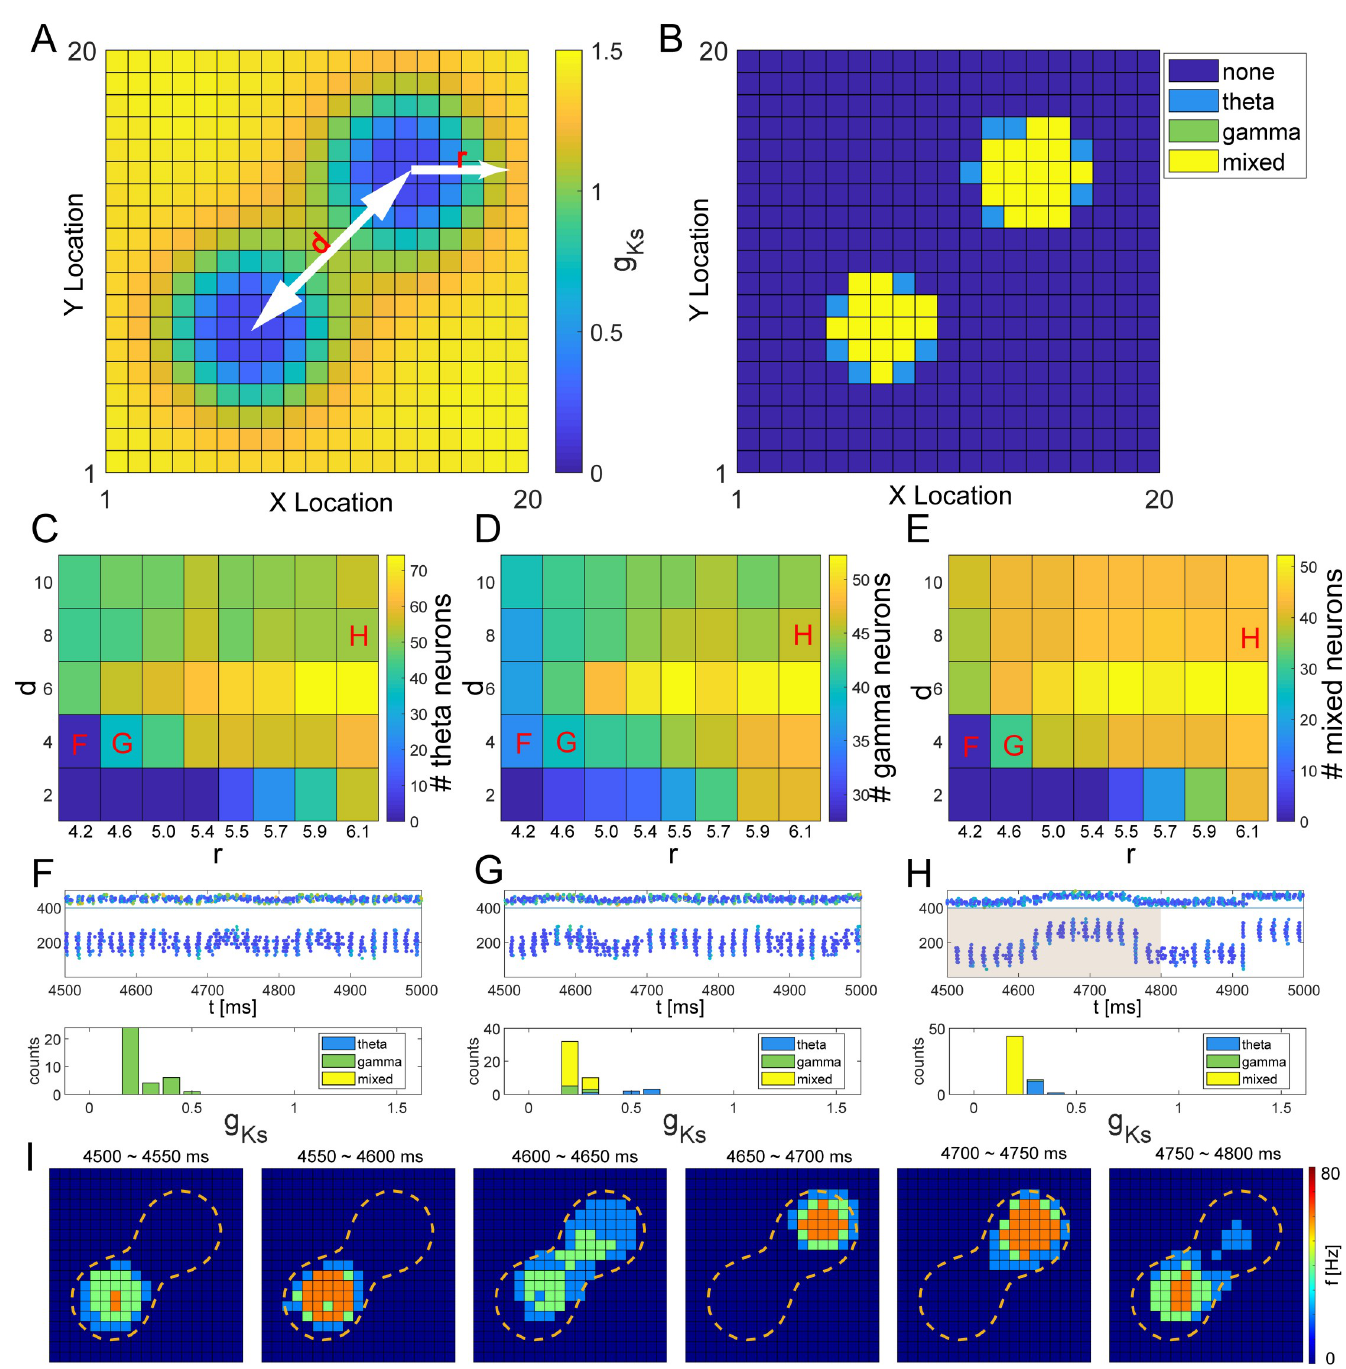
Fig 4. Theta/gamma band rhythms generated with a double peaked spatial distribution of g Ks . A, Example of double peaked spatial mapping of g Ks values for corresponding neurons on the 20 × 20 E cell lattice for hotspot radius r = 4.6 and distance between hotspot centers d = 8. B , Dominant rhythmic activity of individual E cells (dark blue = none, light blue = theta band, green = gamma band and yellow = mixed, both gamma and theta) plotted at cell position on the E cell lattice due to double peaked g spatial distribution shown in A . C, D and E , Numbers of neurons exhibiting dominant theta ( C ), dominant gamma ( D ), or theta-gamma coupled Ks activity ( E ) as a function of radius of g Ks hotspots r and the distance between hotspot centers d for a double peaked g Ks spatial distribution. F, G and H , Spike raster plots (top panels) and histograms for the dominant rhythmic activity exhibited by neurons based on their individual g Ks values (bottom panels) for networks with double peaked g distributions with r and d values indicated by labels in C, D, E. In the raster plots, E cells are numbered 1 to 400, and I cells are numbered 401 to 500. Color Ks indicates g Ks values of cells with the scale in A. I , Snapshots of E cell firing rates from 4500–4800 ms during the simulation in H (shaded area in H; r and d values indicated by label H in C). Cells inside the orange contour lines have g values less than 0.6 mS/cm 2 K s